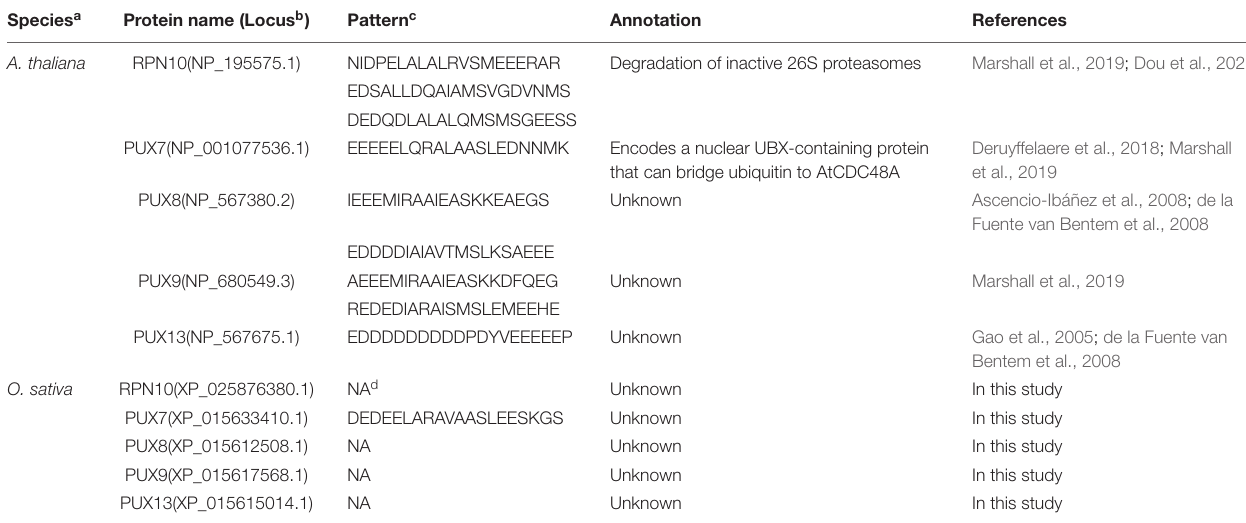
TABLE 2 | Known the ubiquitin-interacting motif proteins in plant. Species